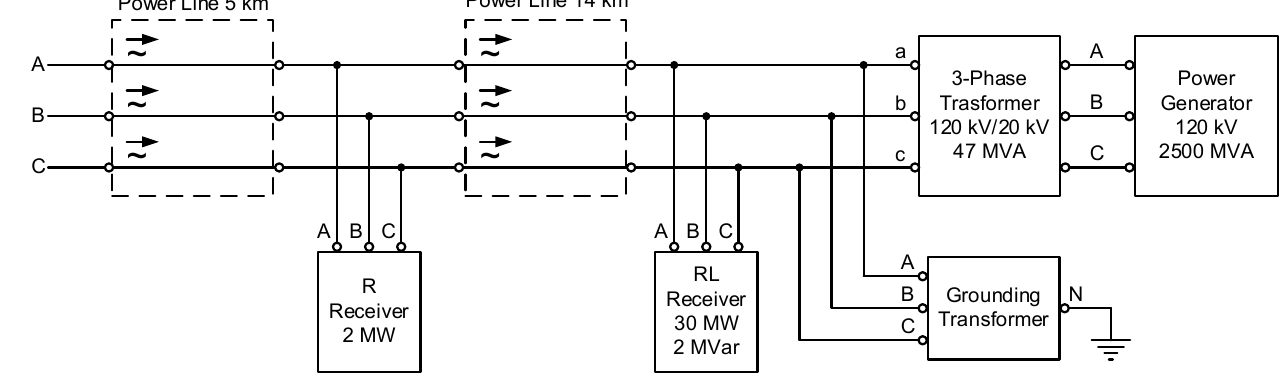
Figure 10. Diagram of the power system implemented in Matlab/Simulink.